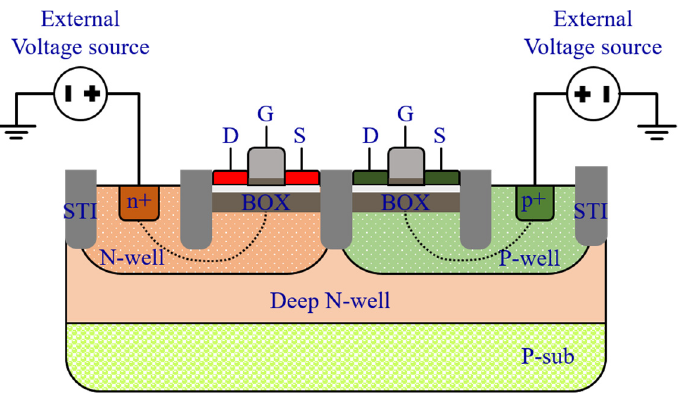
Figure 4. A symbolic cross section of the FD-SOI CMOS technology with the flip well MOSFETs and the body biasing illustration. the body biasing